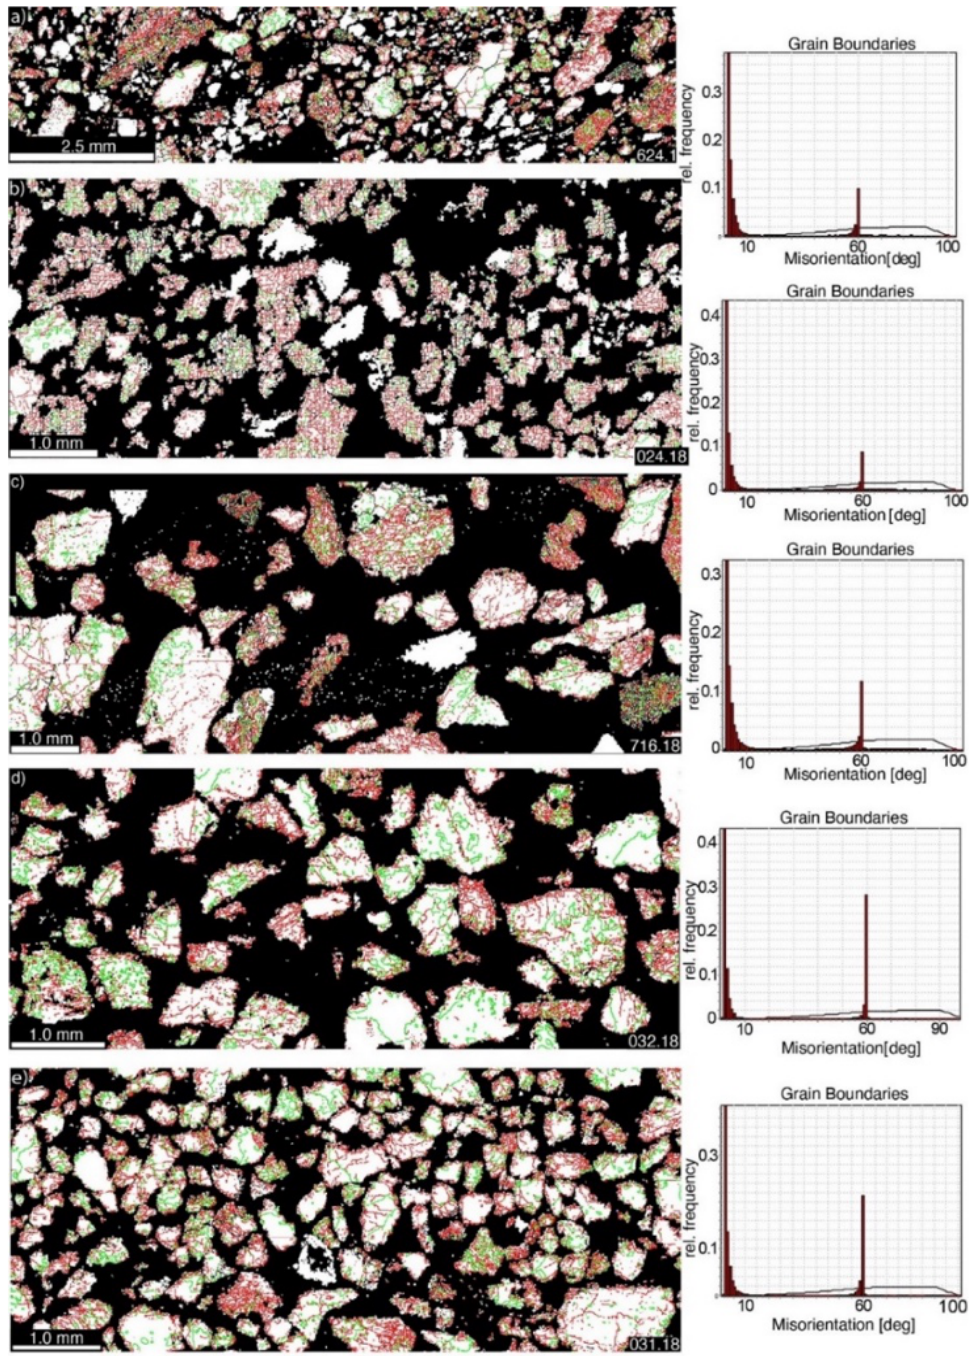
Figure 6. Images of the grain boundary maps of the sand samples and the histogram of misorientation angle distribution. Note: the color in red present the miso rientation angle around 60˚ (Dauphiné Twinnin), and the green color, the higher angles of the grain boundaries or